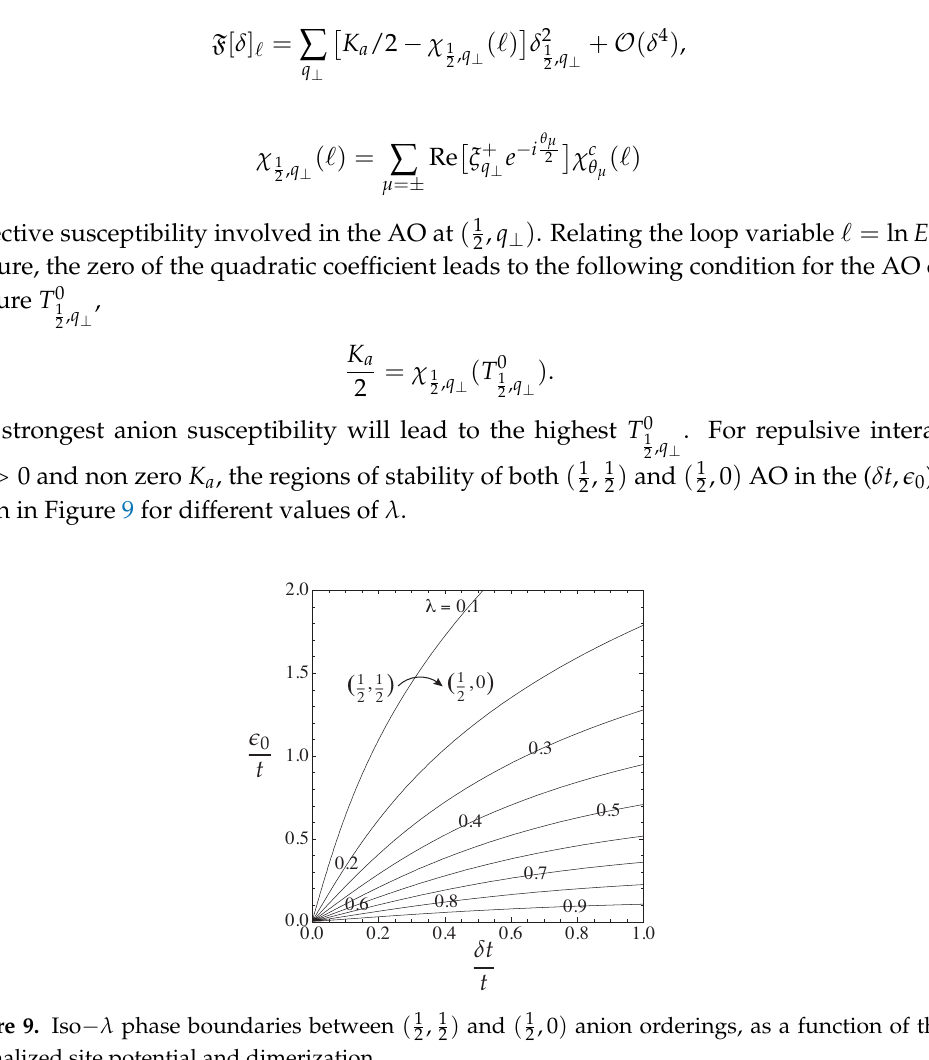
Figure 9. Iso λ phase boundaries between ( 1 − normalized site potential and